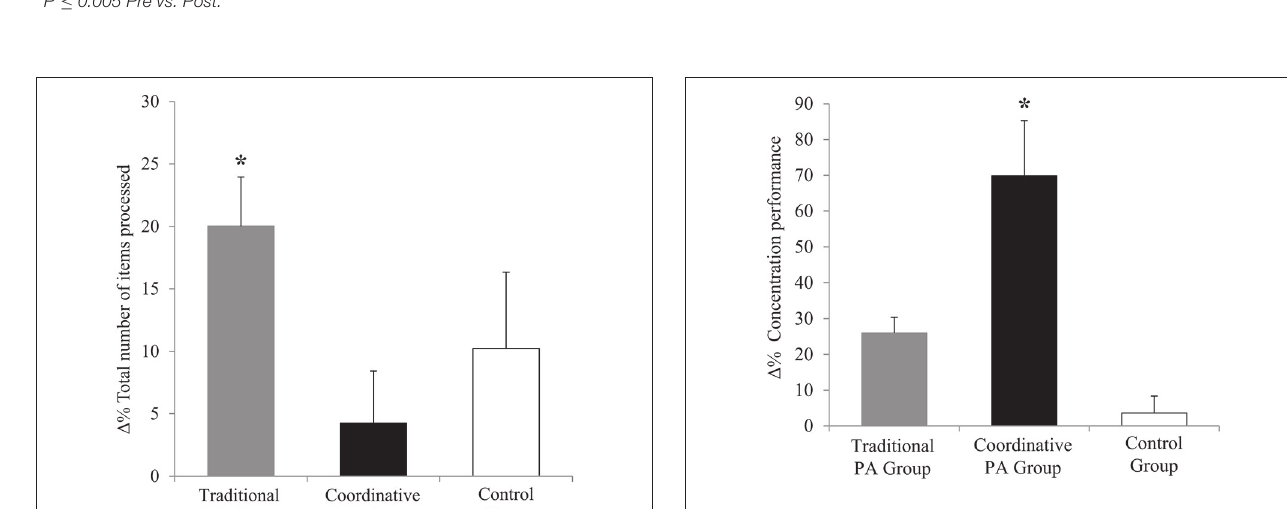
FIGURE 3 | Percentage of variation ( ∆ %) of concentration performance ( ± SEM). ∗ P < 0.05 Coordinative PA Group vs. Traditional PA Group vs. Control